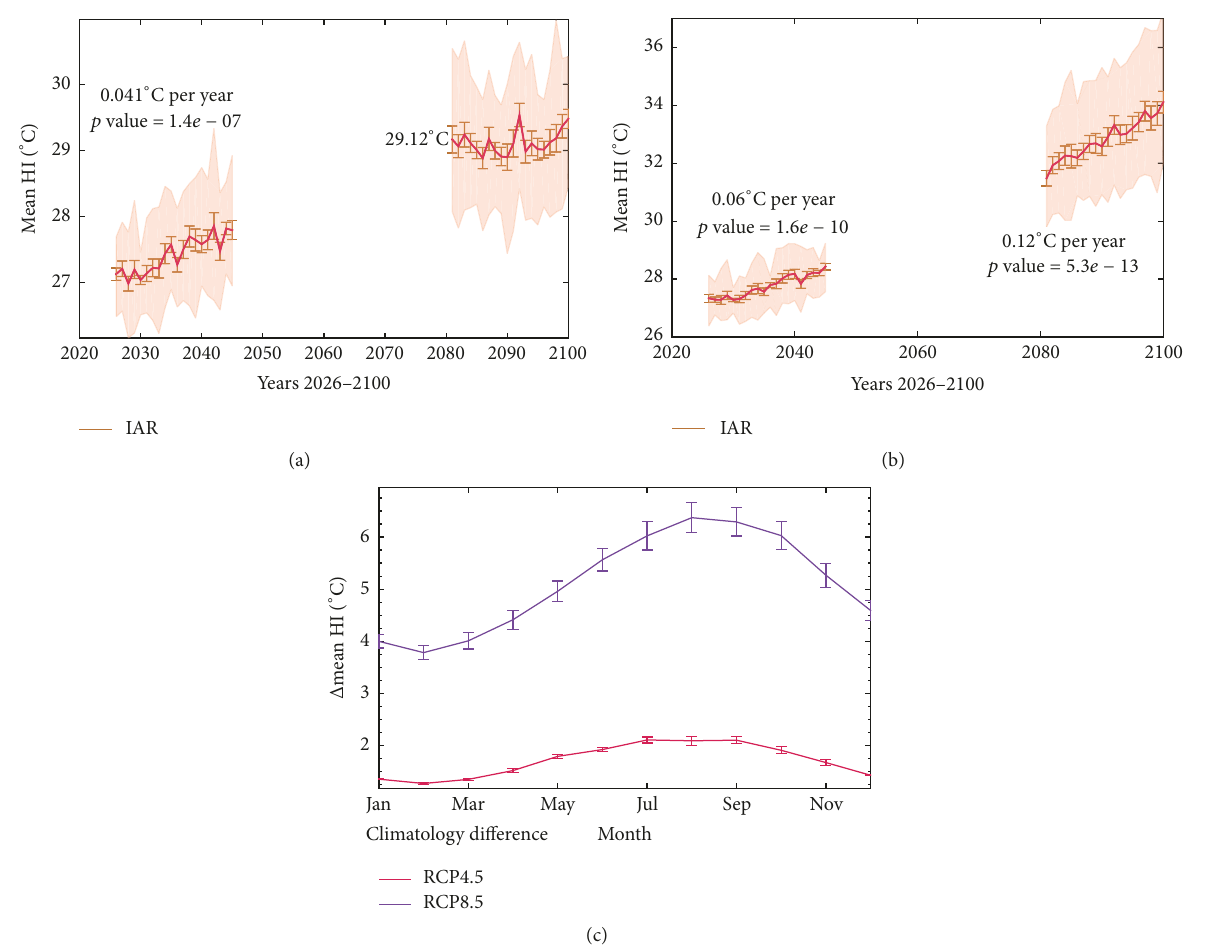
Figure 7: Multimodel ensemble mean for (a) annual mean HI time series, RCP4.5 scenario. (b) Annual mean HI time series, RCP8.5 scenario. (c) HI climate difference for RCP4.5 and